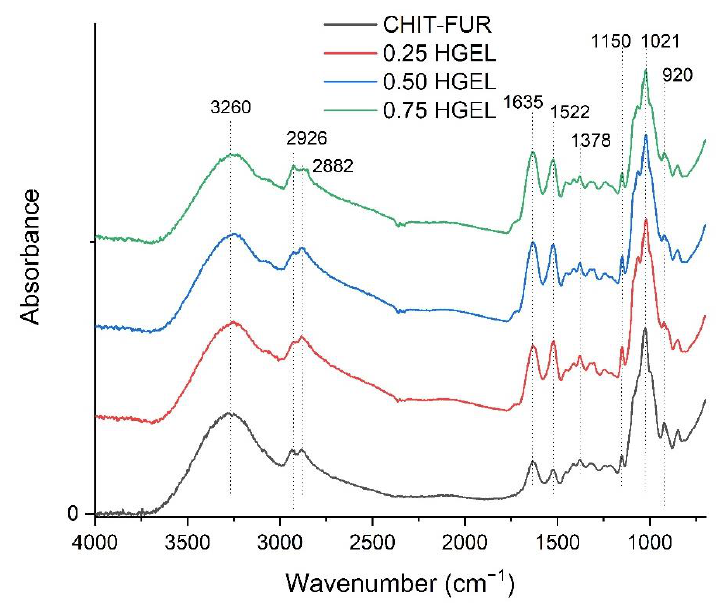
Figure 1. The FTIR-ATR spectrum of furcellaran, chitosan and their complexes with HGEL. In multicomponent systems, such as the ones presented in this paper, many char- acteristic bands overlap and broaden. A wide band from approx. 3130 to 3500 cm − 1 cor- responds to – OH stretching absorption peaks of chitosan, furcellaran and amine NH symmetric vibration. In turn, the bands at 2926 and 2882 cm − 1 correspond to CH stretch- ing, while the peak at 1378 cm − 1 is assigned to vibration of C-H. Within the range from 1150 – 920 cm − 1 , we can observe C-N stretching vibrations overlapping the vibrations from the carbohydrate ring. The addition of HGEL to the CHIT – FUR film caused an in- crease in the intensity of the peaks at ~1635 cm − 1 (amide-I, CO and CN) and ~1522 cm − 1 (amide-II). Such behaviour may indicate an interaction between the free negative sul- phate groups of FUR and the positively charged amide groups of HGEL [19]. In addi- tion, slight shifts and changes in peak intensity were observed, while no new peak was noted in the CHIT – FUR-HGEL composite layer compared to the pure CHIT – FUR one, indicating that the film components were compatible. Zhang , et al. [23] came to similar conclusions obtaining chitosan-based films and a rapeseed protein hydrolysate. 3.2. Thermal Properties of CHIT – FUR and CHIT – FUR/HGEL The thermal properties of the films are important features in the selection of storage and processing conditions, as well as potential application. From this point of view, the thermal characteristics of polysaccharide-based films can provide a better understanding of the polysaccharide film distribution as well as information on the stability of biopol- ymer films [24]. The DSC parameters of the melting peak: temperature (T m ) and the transition enthalpy change (∆H) of tested films are shown in Table 1 . The melting tem- perature values ranged from 190.3 °C for the film based on the CHIT – FUR complex to 201.6 °C for the film with 0.5% HGEL addition. However, the performed statistical anal- ysis showed that the mean values of melting points for the analysed films did not signif- icantly differ. Nonetheless, it was found that values of melting enthalpy concerning films with the HGEL addition were significantly lower compared to the pure CHIT – FUR matrix, which shows that the presence of HGEL in the film structure reduces the amount of heat needed for structure melting of CHIT – FUR/HGEL complexes. The statistical dif- ferences between the average ∆H values for fi lms with different HGEL levels were